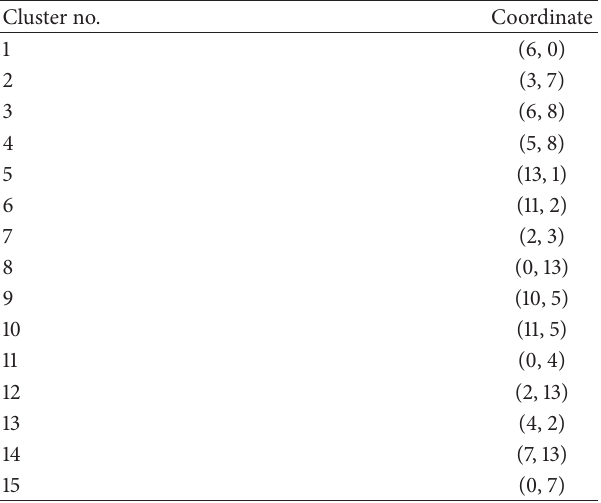
Table 2: Results of distribution based on force analysis. Cluster no.